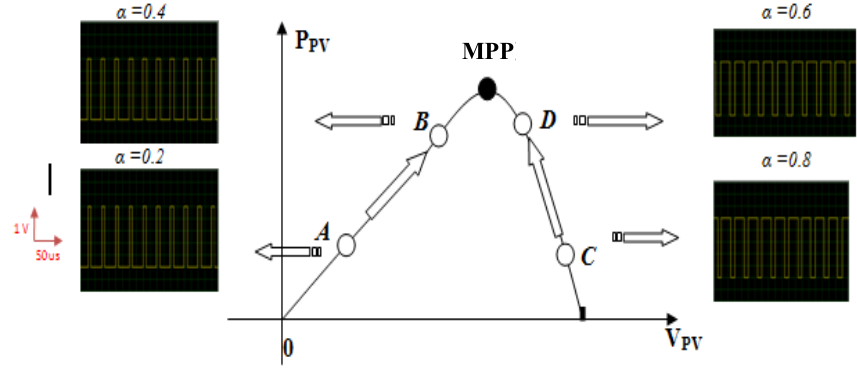
Figure 4. Variations of the simulated PWM signal used to view its influence on the PV panel